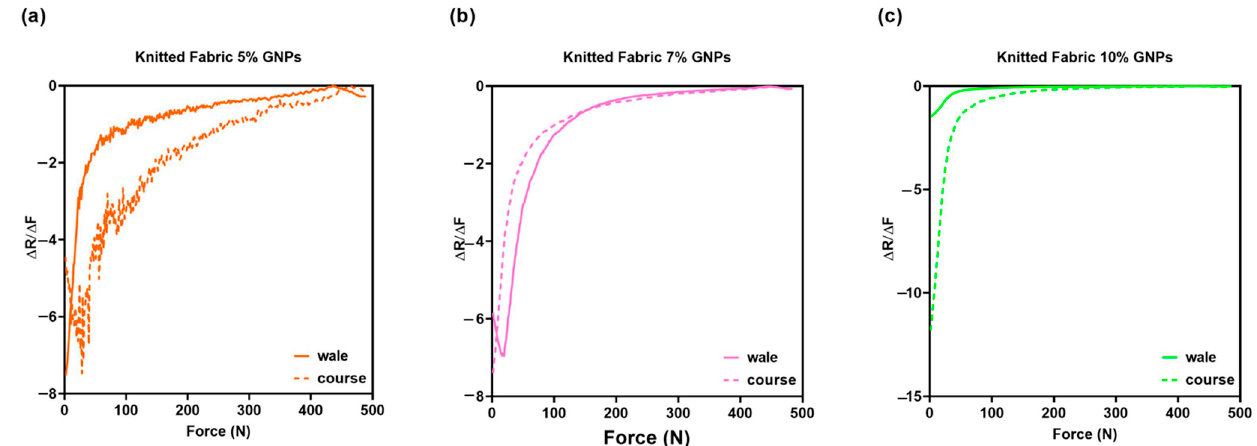
Figure 15. Sensitivity (S) of ( a ) knitted fabric doped with 5% GNPs, whose active material was assembled towards the walewise (continuous line) and towards the coursewise directions (dotted line); ( b ) knitted fabric doped with 7% GNPs, whose active material was assembled towards the walewise (continuous line) and towards the coursewise directions (dotted line); ( c ) knitted fabric doped with 10% GNPs, whose active material was assembled towards the walewise (continuous line) and towards the coursewise directions (dotted line).